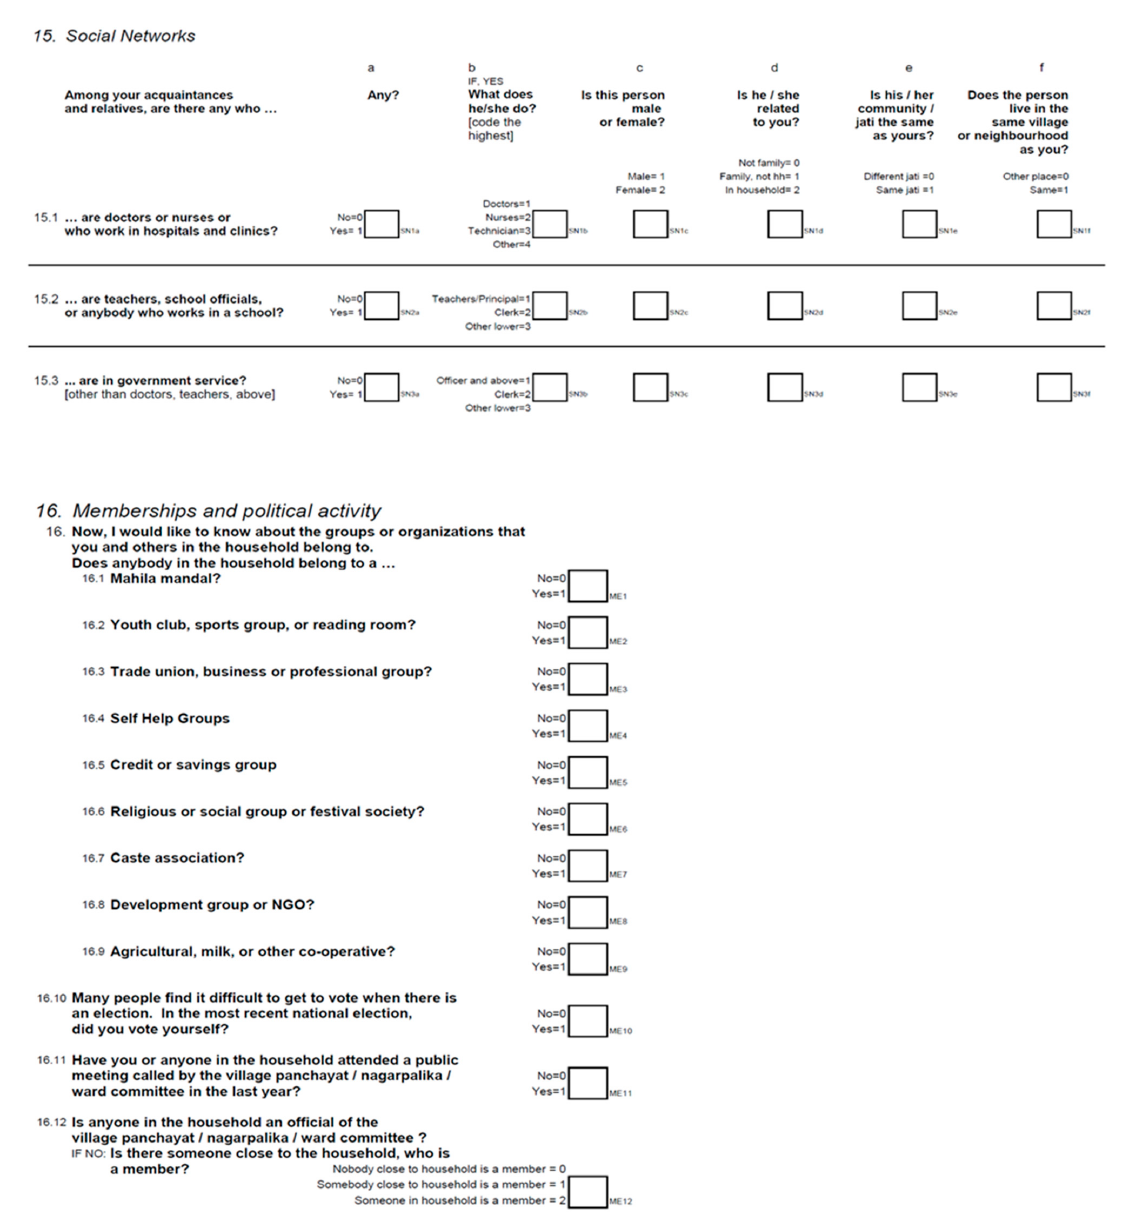
Figure A2. Sample Household Questionnaire: Questions 15 and 16 are related to social network measures.